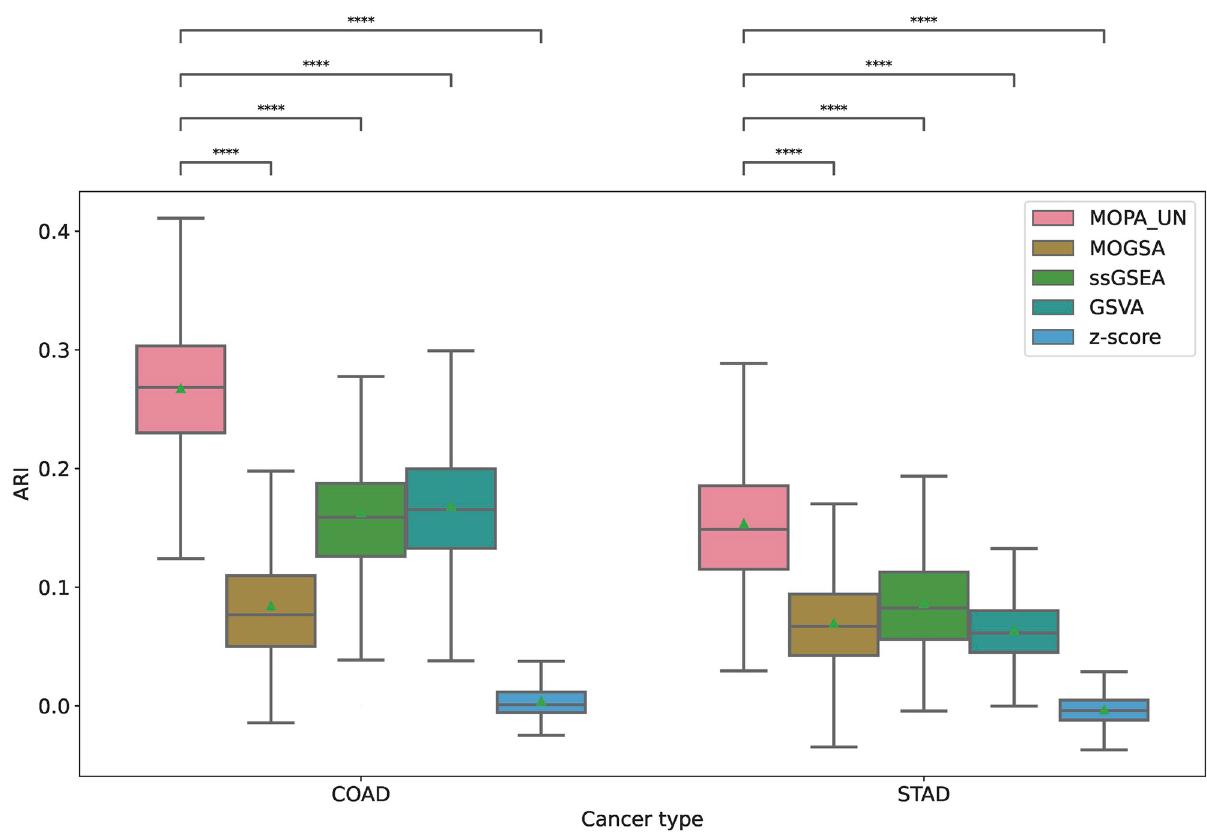
Fig 9. Comparison of the clustering quality. The ARI of COAD and STAD samples clusters was measured using their molecular subtype labels as ground truth labels (color coded).